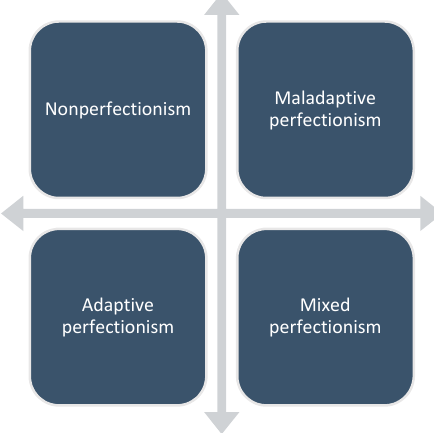
Figure 1. The 2 × 2 model of perfectionism (Gaudreau and Thompson, 2010).